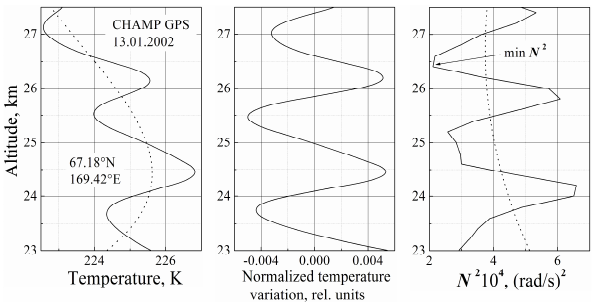
Figure 3. The same as Fig. 1, except from radio occultation made in the high latitudes of the Earth’s atmosphere on 17 January 2002.